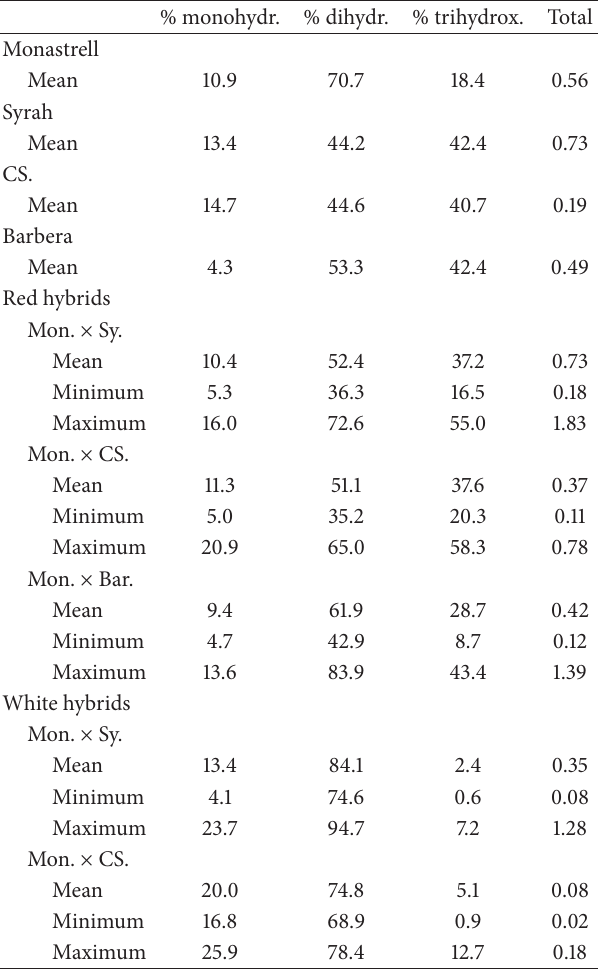
Table 2: Mean values of the flavonol profile and total flavonol content (mg/g fresh skin) in Monastrell, Syrah, and Cabernet Sauvignon grapes and their hybrids ( 𝑛 = 3